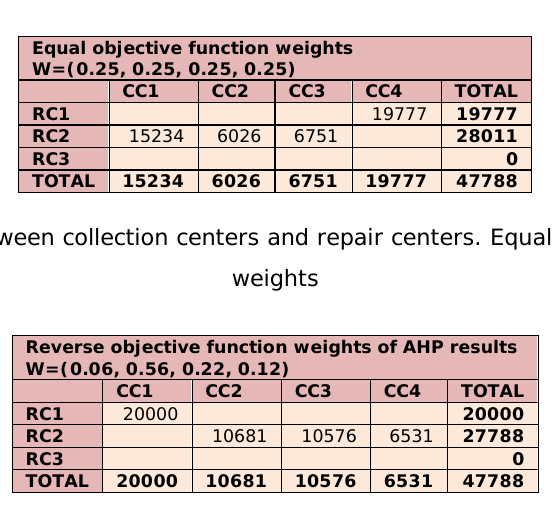
Table 9. Flows between collection centers and repair centers. Reserve objective